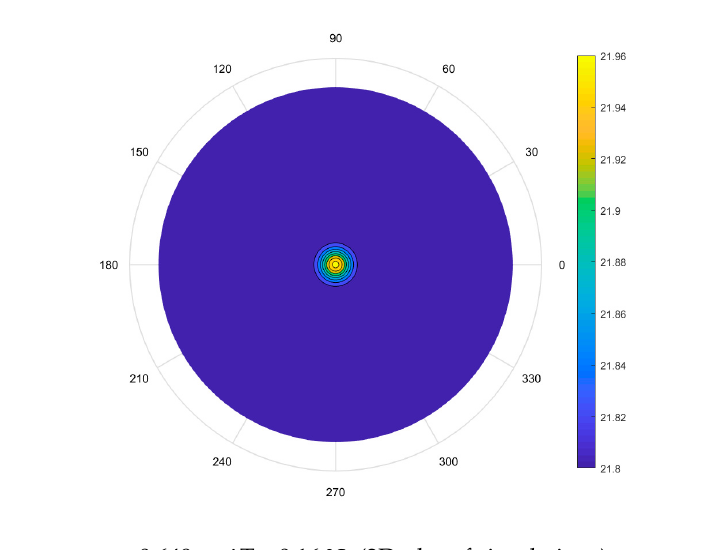
t = 0.649 s, ∆ T = 0.16 ℃ (2D plot of simulations) ( c ): The ∆ T images of the CFRP specimen after the impact with a steel ball (experiments vs. simulations). Figure 11. Cont